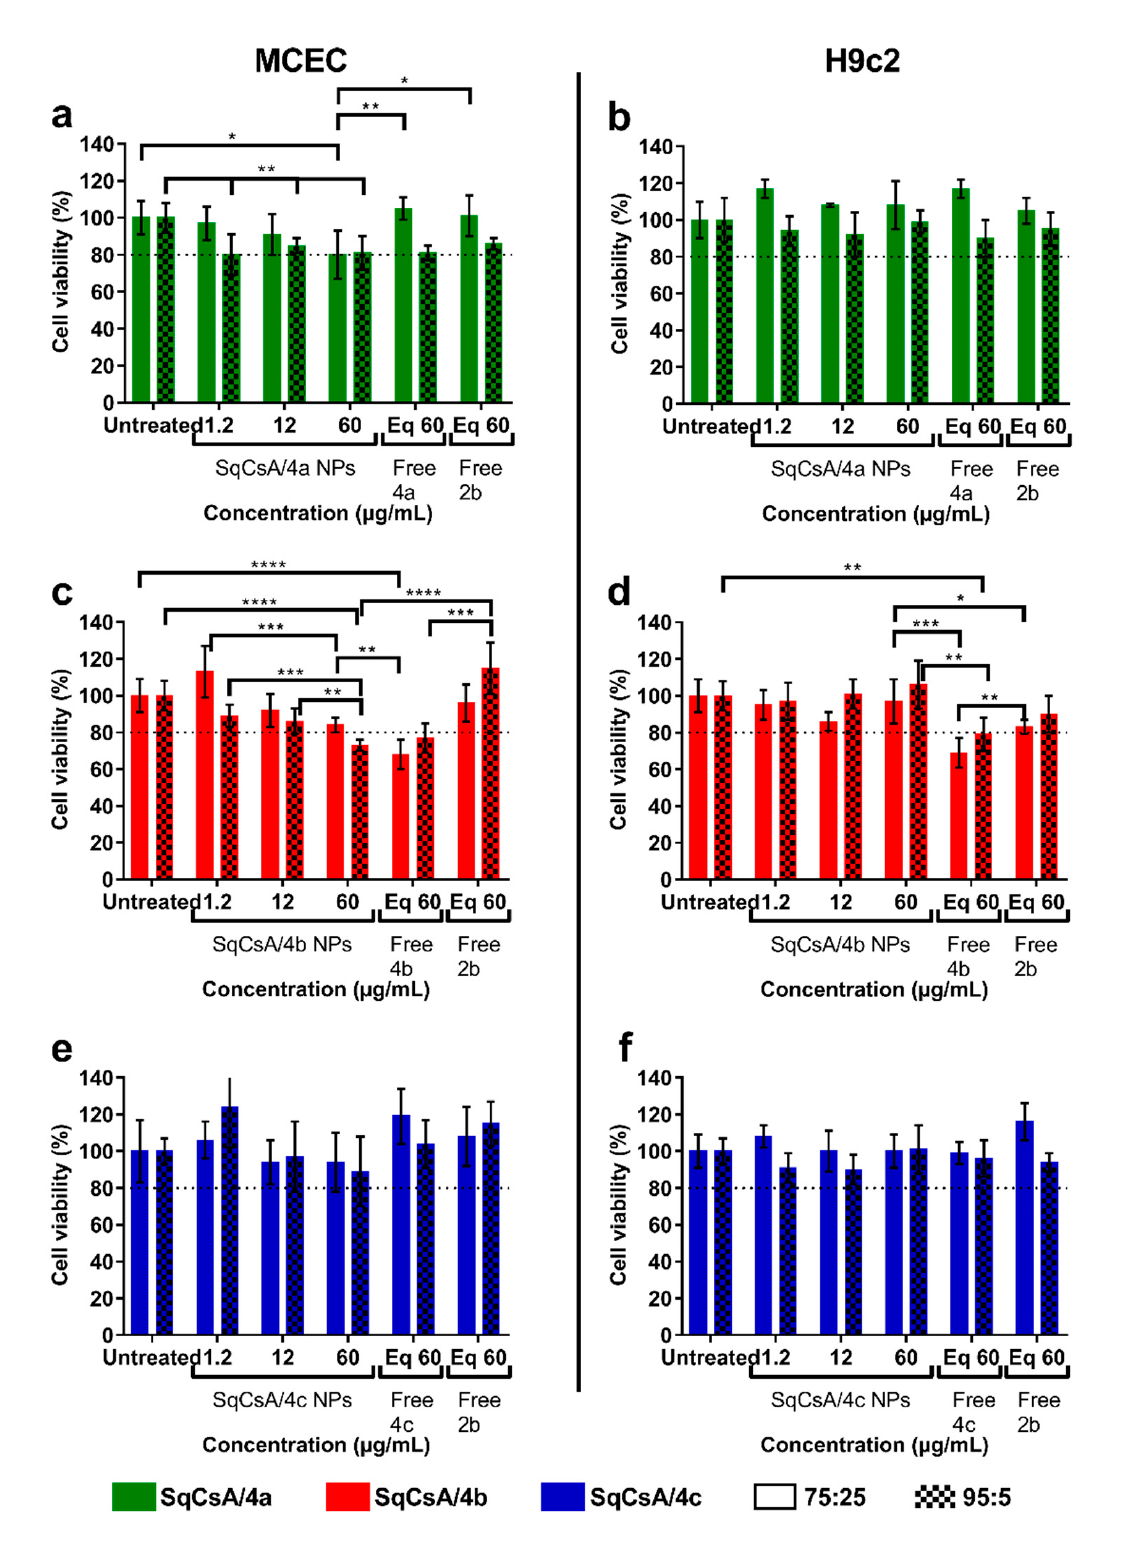
Figure 5. Cell viability assessment of Mouse Cardiac Endothelial Cells (MCEC) ( a , c , e ) and H9c2 ( b , d , f ) cells treated either with SqCsA/ 4a ( a , b ), 4b ( c , d ) or 4c ( e , f ) NPs. Cell viability was expressed as a percentage of the viability of untreated cells. An equivalent concentration (eq) of free bioconjugate 4a ( a , b ), 4b ( c , d ) or 4c ( e , f ) or the free peptide ( 2b ) contained in the nanoparticles at the highest concentration was used as control. * p ≤ 0.05, ** p ≤ 0.01, *** p ≤ 0.001, **** p ≤ 0.0001. C 32 squalene acid was found to be the best candidate for further experiments based on polydispersity index (below 0.2) and cell viability (above 80%). Furthermore, the cytotoxicity of SqCsA/ 3a NPs was also studied on both cell lines and the results were similar to those obtained for SqCsA/ 4a NPs with a slight cytotoxicity at higher doses (Figure 6). Furthermore, cytotoxicity appeared to be significantly higher for an equivalent of SqCsA NPs or free CsA compared to SqCsA/ 3a NPs on both cell lines (Figure S2). Overall, cell viability appeared to be lower with the 95:5 ratio than with the 75:25 ratio,